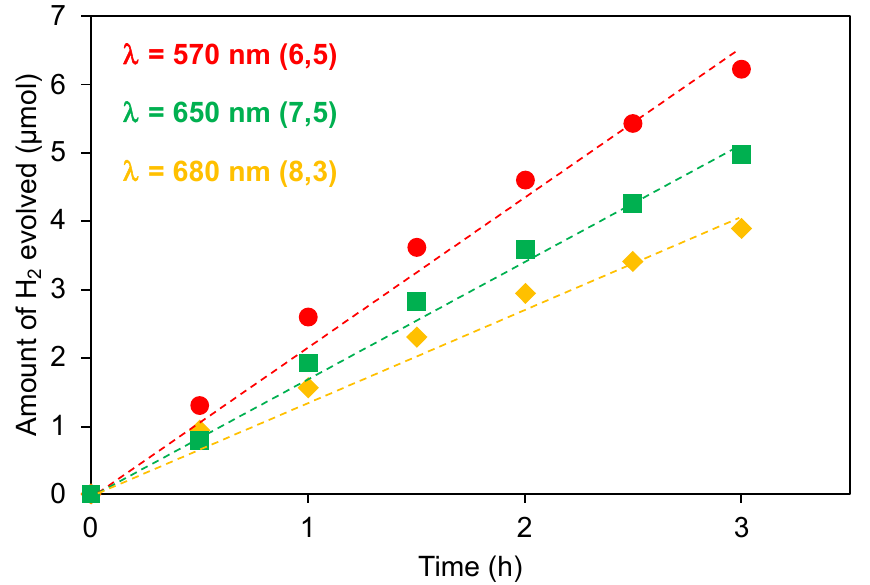
Figure 8. Time course of the H 2 evolution under irradiation at 570 nm (E 22 of the (6,5)SWCNT; ●), 650 nm (E 22 of (7,5)SWCNT; ■ ), and 680 nm (E 22 of the (8,3)SWCNT; ▲ ).